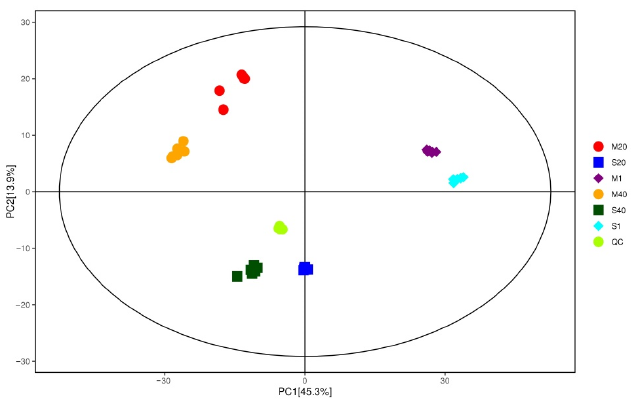
Figure 4. Score scatter plot of PCA model for all groups. Abbreviations: M, mixed-fermentation cheese; S, single-strain-fermentation cheese. Numbers 1–40 represent different ripening times (in days).